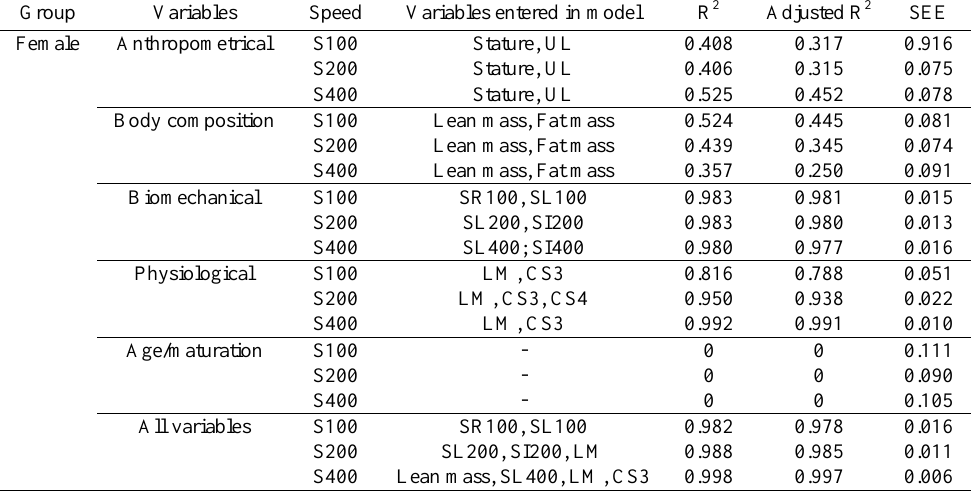
Table 3. Multiple linear regressions to determine the group of parameters (i.e., anthropometrical, body composition, biomechanical, physiological, age/ maturation, all variables) that best predict 100, 200 and 400 m performances in